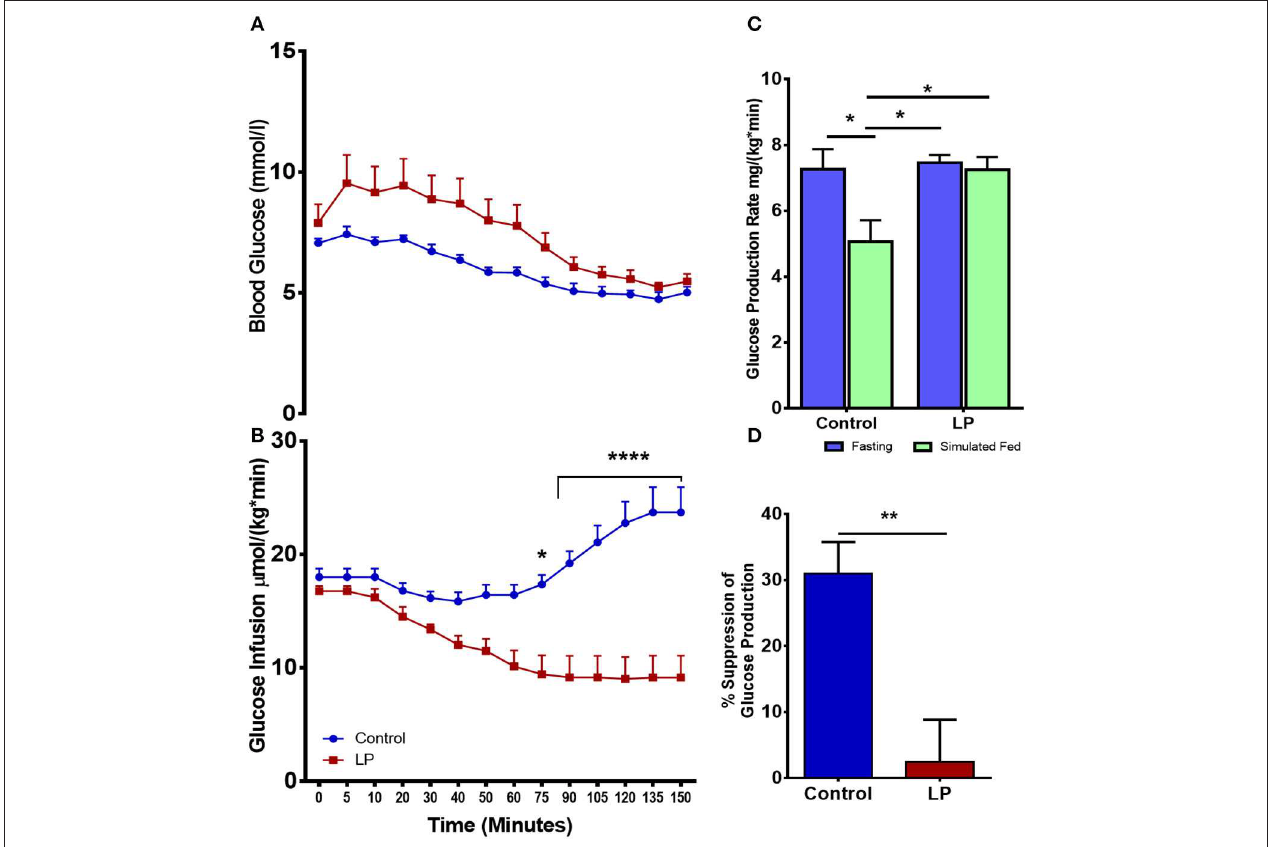
FIGURE 2 | Impaired insulin induced suppression of glucose production during fasting and simulated fed state from 6 month old male lean type 2 diabetic (LP) rats. (A,B) Euglycemic hyperinsulinemic clamp for low protein diet programmed lean type 2 diabetic (LP) males in comparison with controls along with (C) total hepatic glucose production rate during fasting and simulated fed state. (D) Percentage suppression of glucose production in males during simulated fed state. * p < 0.05, ** p < 0.01, and **** p < 0.0001, n =